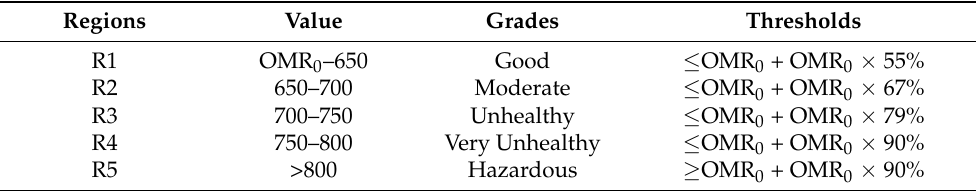
Table 1. Grades of OMR during growth seasons over 1982–2020.